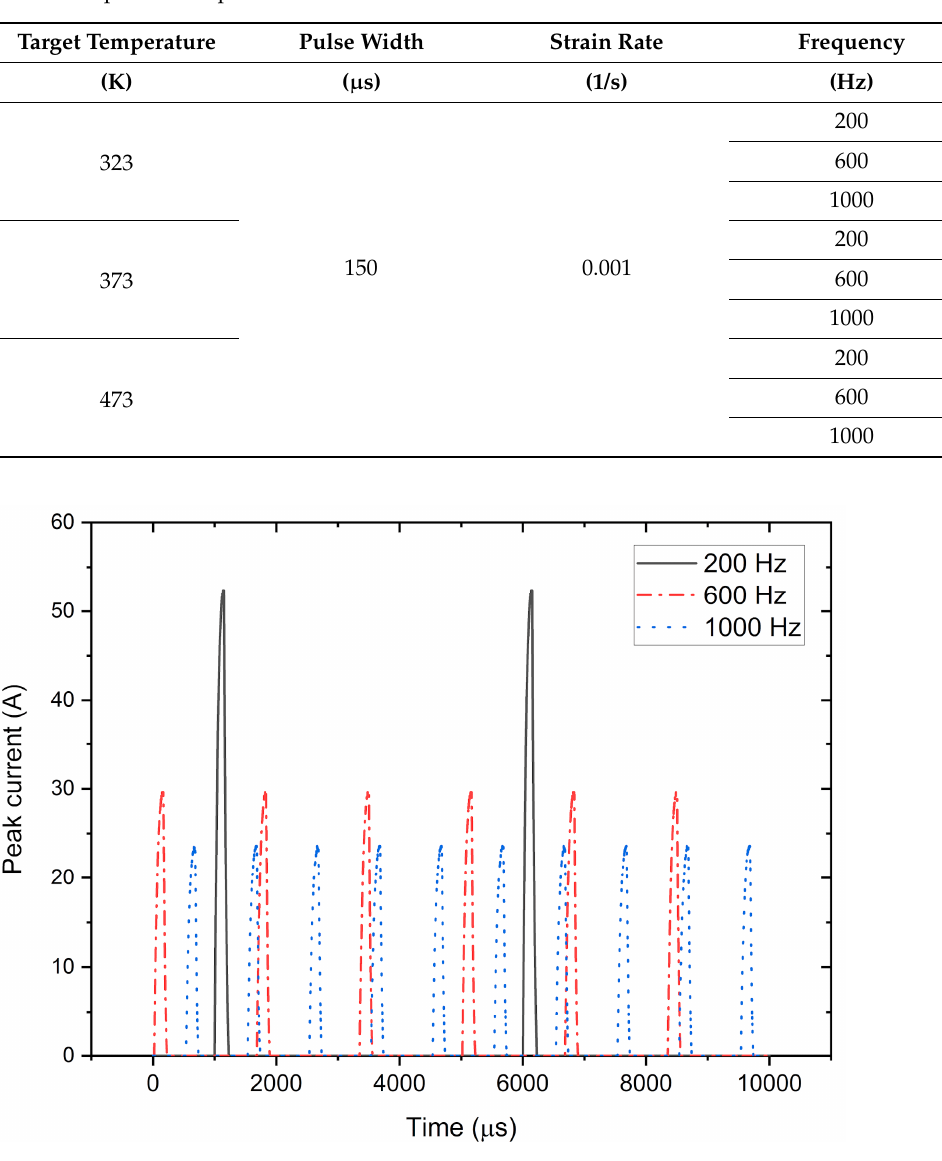
Figure 3. Schematic illustration of the pulsed pattern applied in this